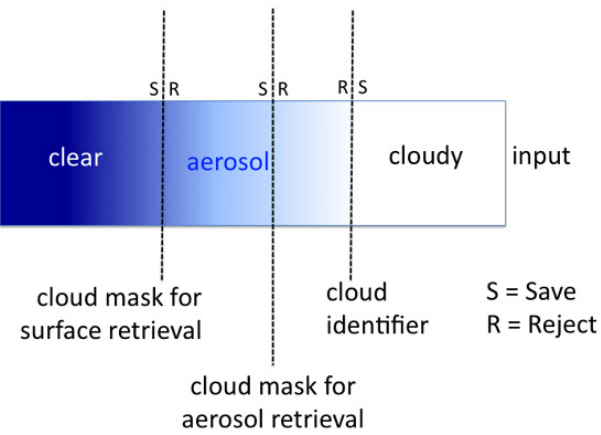
Fig. 1. Schematic illustrating thresholds of input used to differen- tiate clear from cloudy for different purposes. For the purpose of a surface retrieval, only the clearest pixels are saved. For the pur- pose of a cloud identifier, only the cloudiest pixels are saved. For the purpose of an aerosol retrieval, a mid-range threshold must be